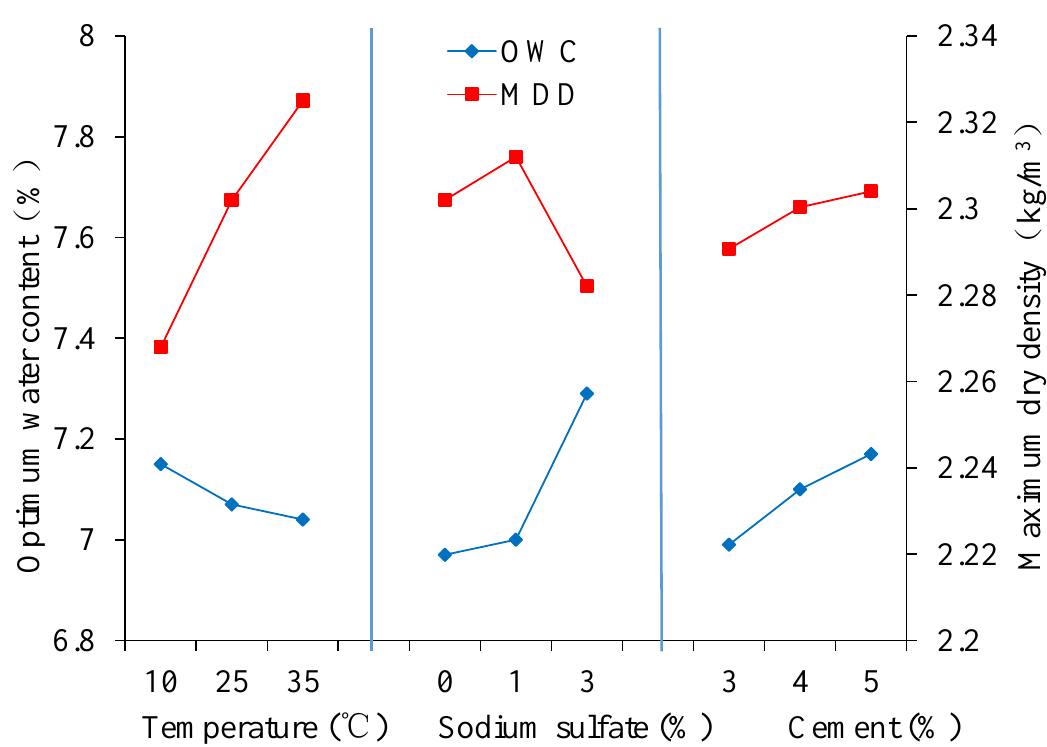
Figure 17. The influence of three factors on the compaction results.